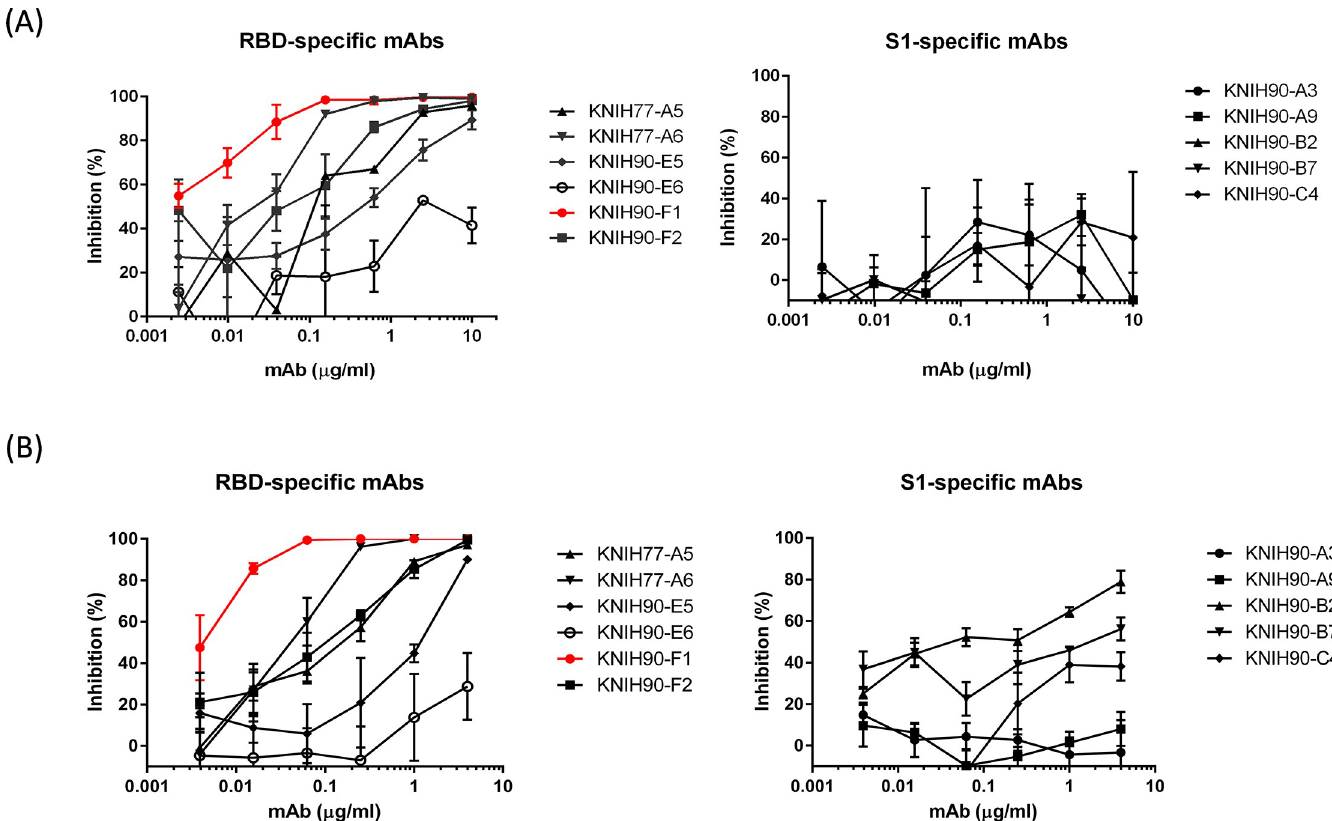
Fig 2. Neutralizing activity of mAbs specific for S1 and the RBD of the S protein. Neutralization potency of RBD and S1-specific mAbs evaluated using a MERS-CoV EMC pseudovirus-neutralization assay (A) and a live-virus PRNT assay (B). The percent inhibition by the mAbs was determined by comparison with untreated cells. Each experiment was performed in triplicate, and data represent the mean of each experiment with standard errors.